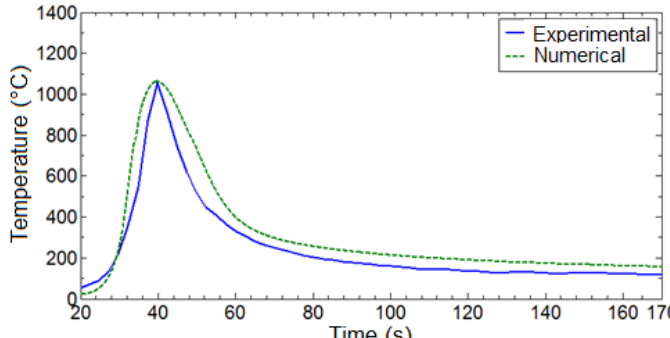
Figure 8. Comparative thermal cycle analysis of the experimental and the numerical method.